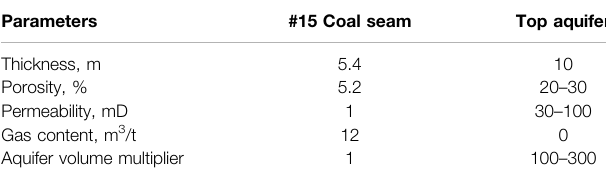
TABLE 1 | Numerical simulation production fi tting parameters.